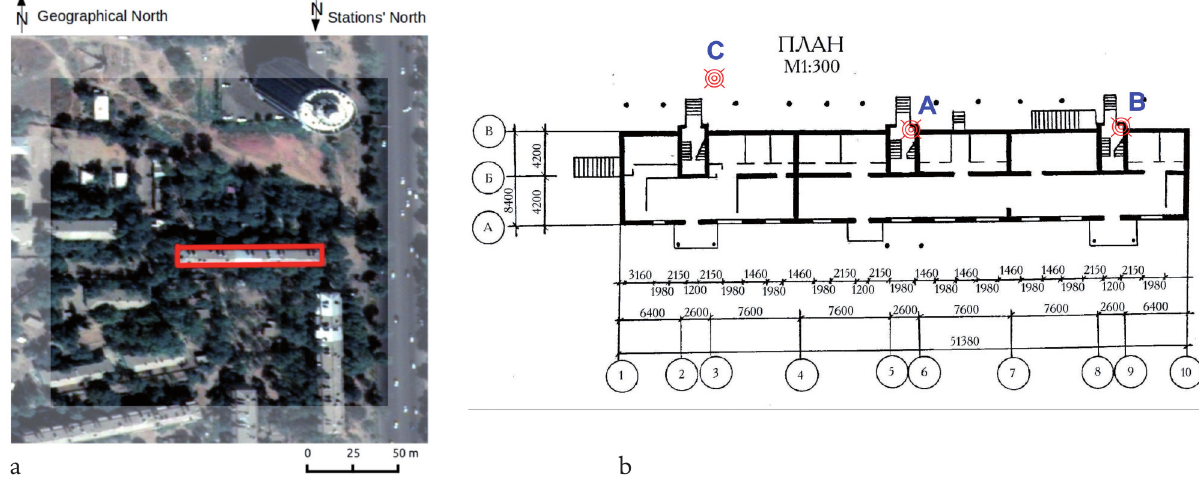
Figure 4. (a) Satellite image and (b) building floor plan of the 4 story confined masonry building (Figure 2,II) , showing the locations of the installed stations (red symbols).